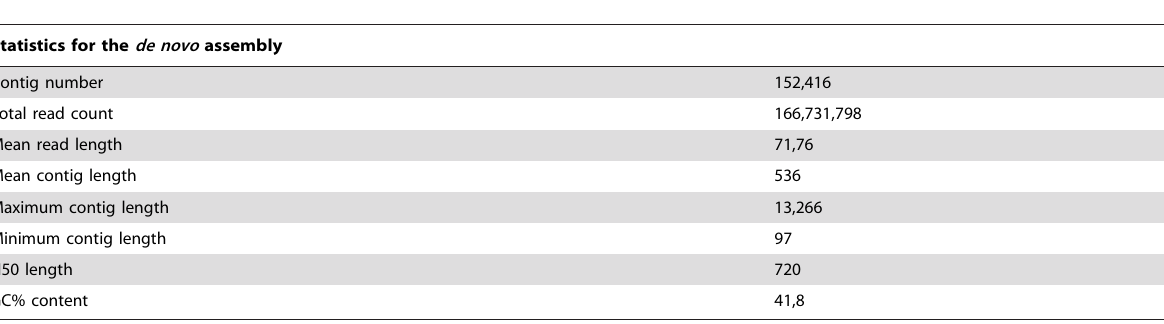
Table 2. Statistical summary of the de novo assembly for H. brasiliensis